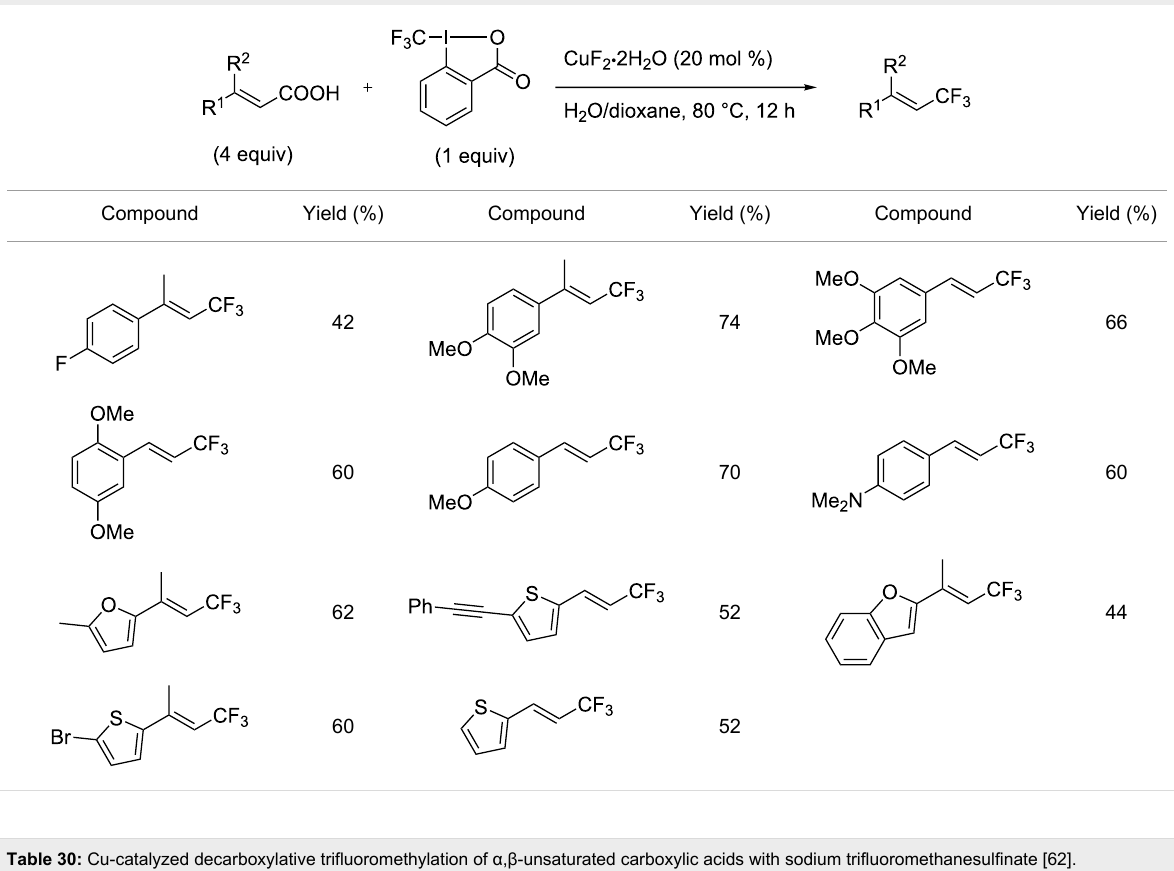
Table 29: Cu-catalyzed C–CF 3 bond formation on α , β -unsaturated carboxylic acids through decarboxylative fluoroalkylation